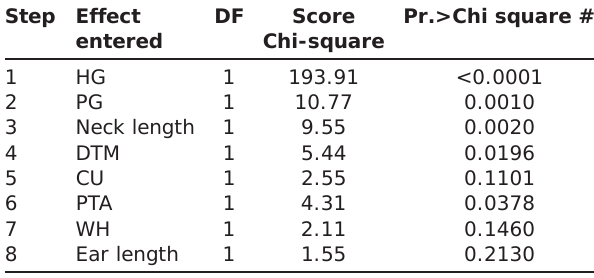
Table-4: Summary of stepwise logistic selection of various body linear traits influencing LZ in Indian Black Bengal goats.